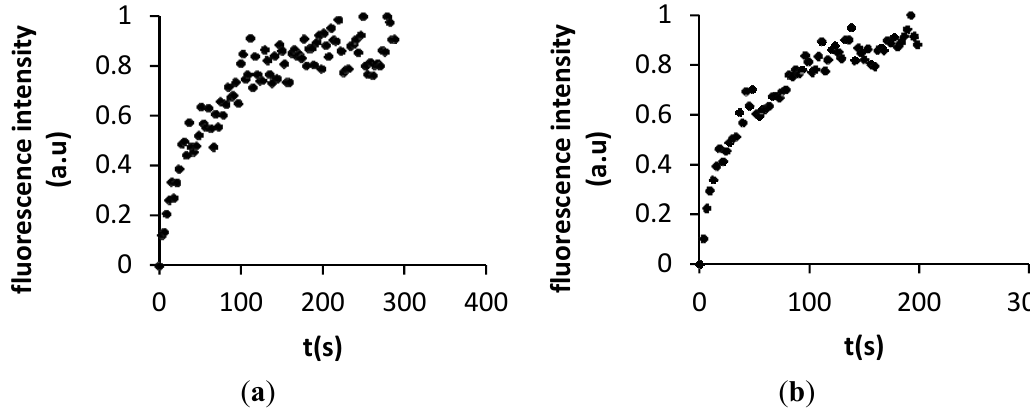
Figure 8. Determination of the mobility for ( a ) OG-DHPE labeled DMPC and ( b ) DOPC deposited onto polydopamine-coated mica from the FRAP normalised fluorescence intensity as a function of time.